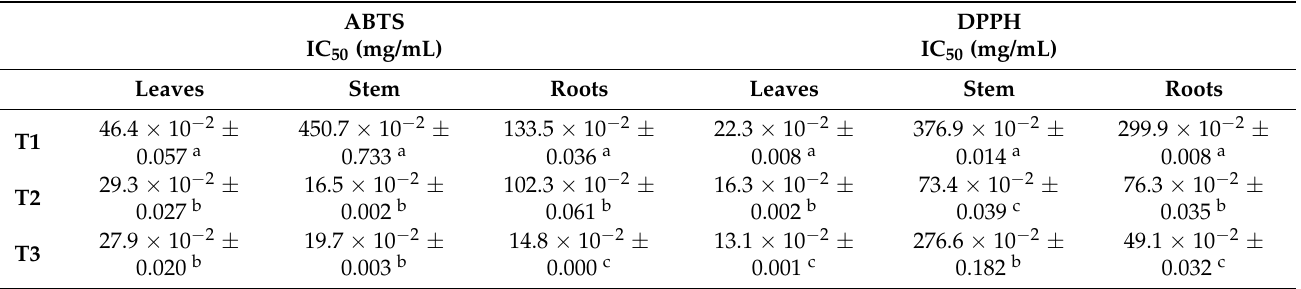
Table 5. The effects of different treatments on the antioxidant activities of the various parts of M. malabathricum L. methanolic